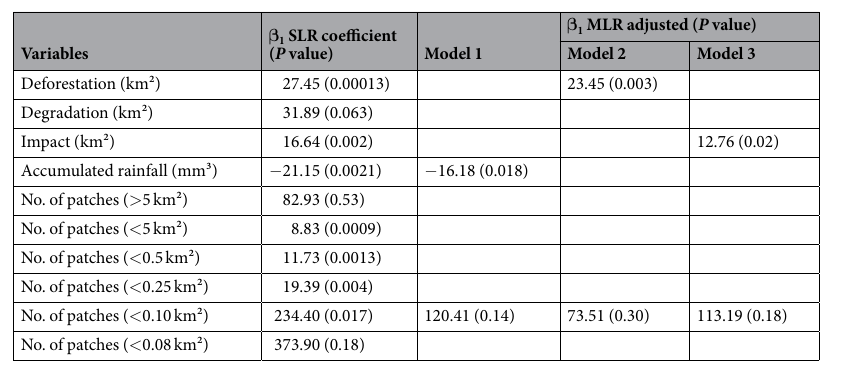
Table 2. Models of simple and multiple linear regression for the variables about deforestation activities, landscape composition (e.g., abundance of patch units), rainfall (environmental parameter) and number of malaria cases in Brazilian Amazonian States. SLR: Simple Linear Regression; MLR: Multiple Linear